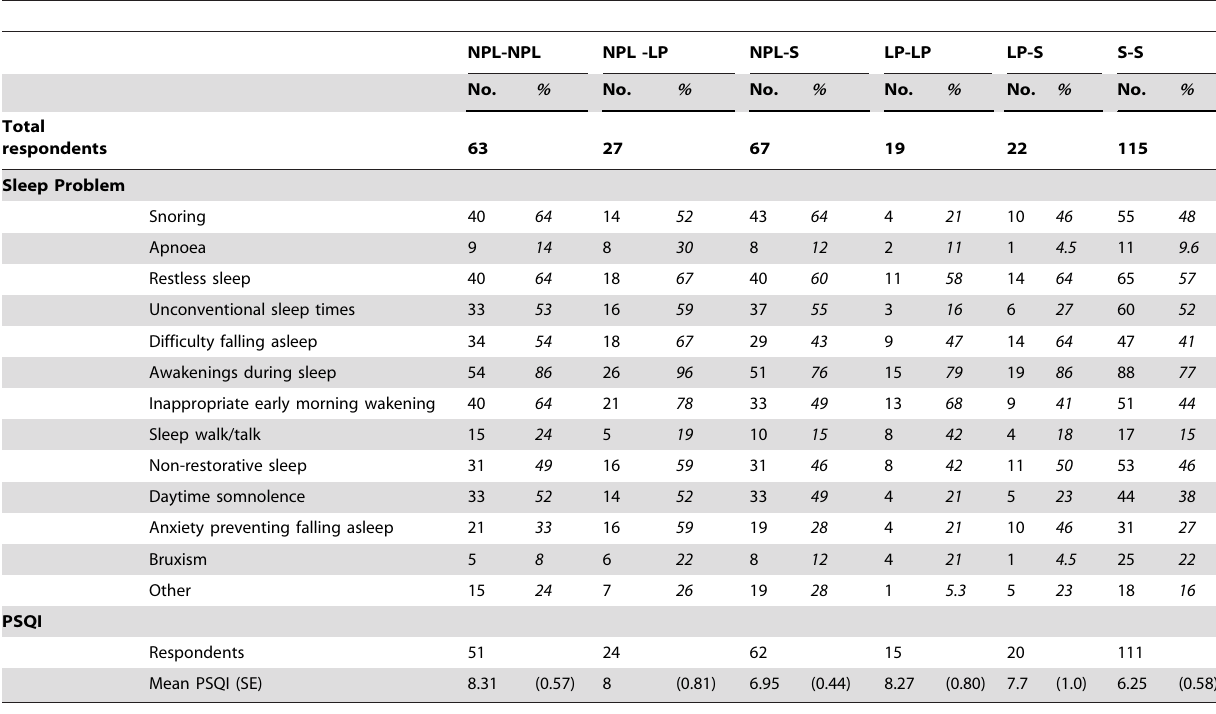
Table 3. Incidence of self-reported sleep disturbances and mean Pittsburgh Sleep Quality Index (PSQI) in the six different sub- groups of the blind and visually impaired respondents.